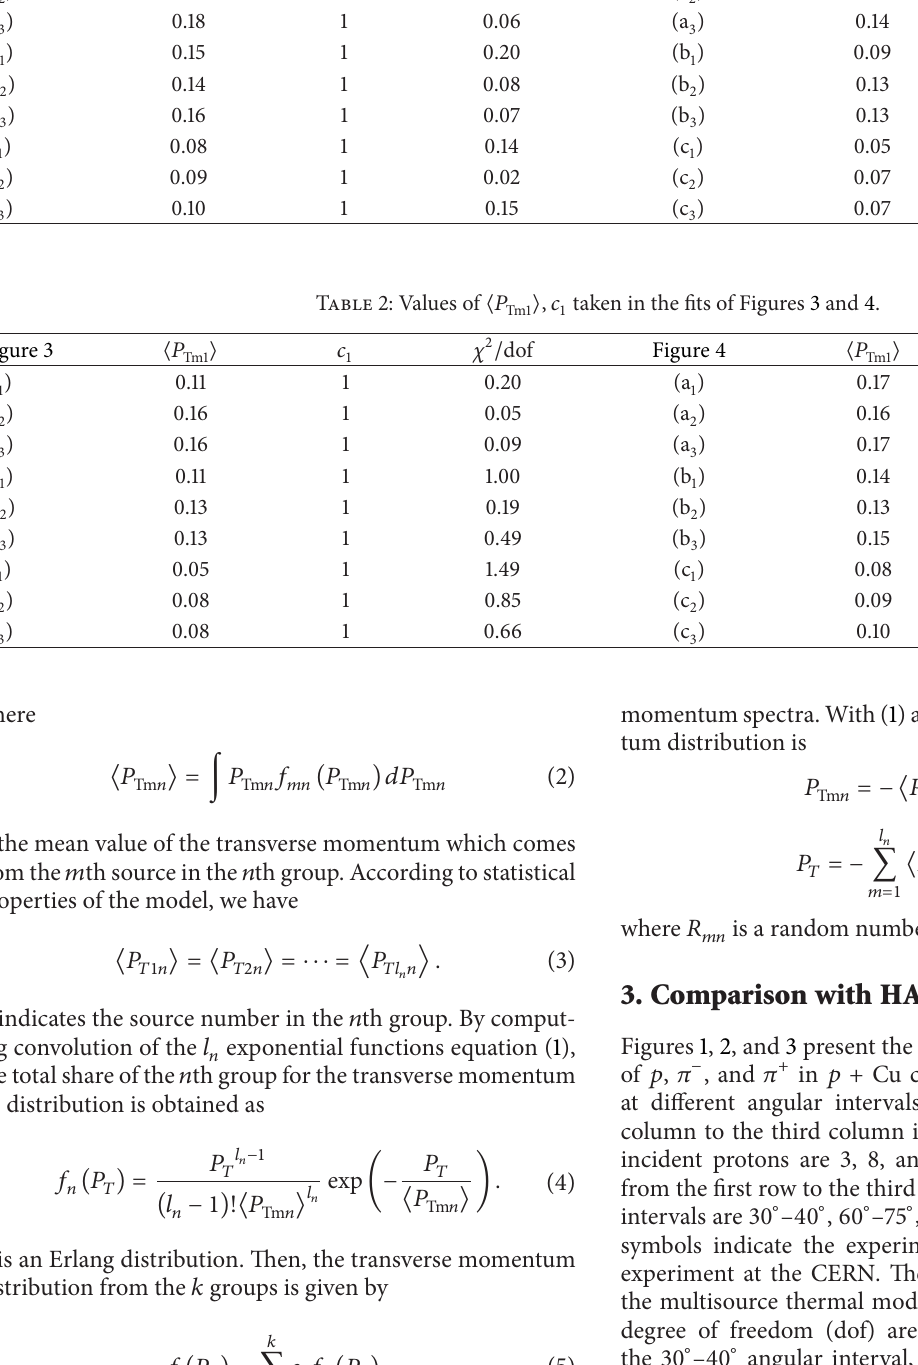
Table 1: Values of ⟨𝑃